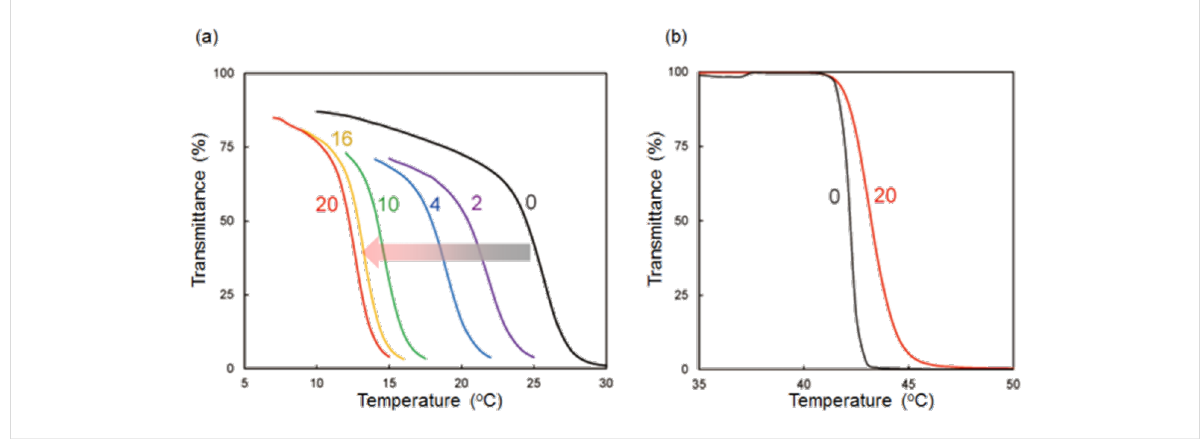
Figure 3: Temperature dependence of light transmittance at 650 nm of an aqueous solution of (a) 3 (2 mM) upon addition of 1,4-dicyanobutane (0–20 mM) and (b) 1 (2 mM) in the presence and absence of 1,4-dicyanobutane (20 mM) on heating.